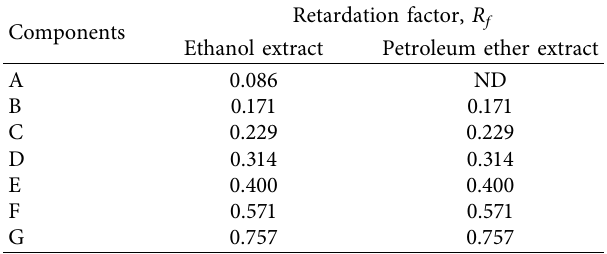
Table 9: TLCs of the less polar constituents of C. nioroense extracts. Table 7: TAC of ethanol and petroleum ether extracts expressed as